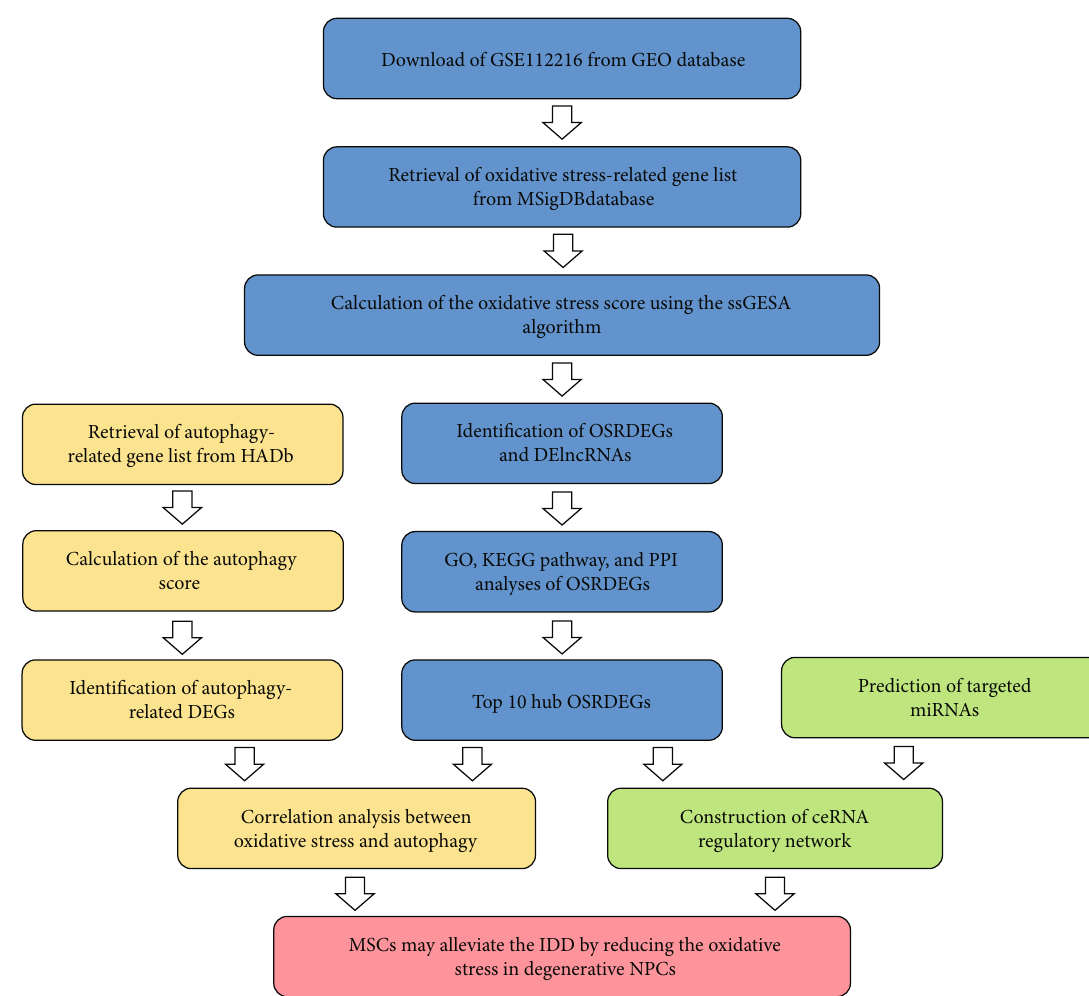
Figure 1: Flow chart of the bioinformatic analysis in the